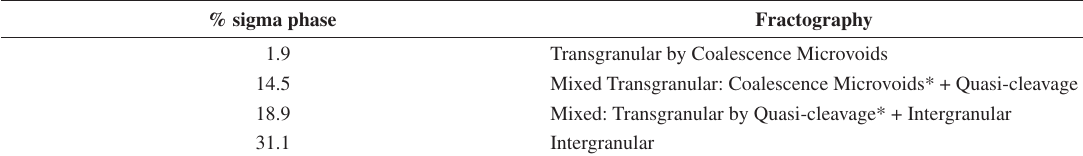
Table 3. Relationship between % sigma phase precipitated and fractography in a 2205 stainless steel (*predominant). % sigma